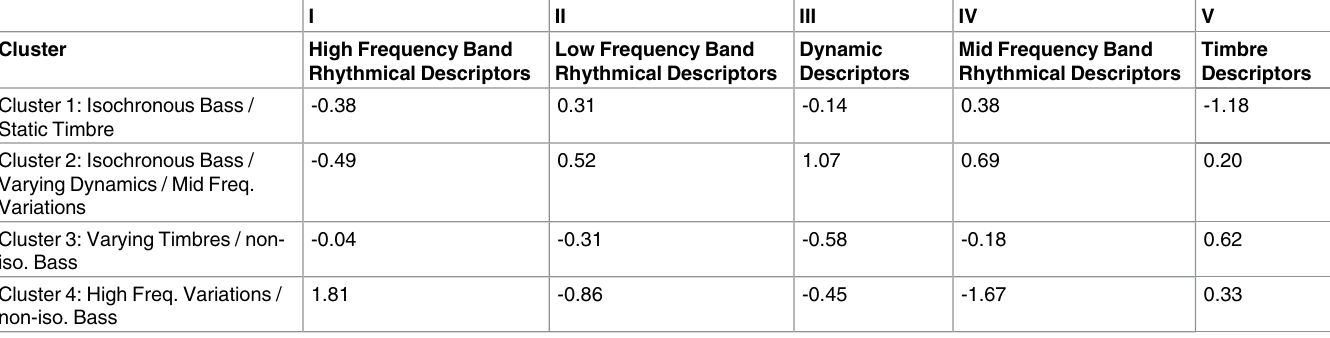
Table 2. Final Four Cluster Centers by Five Factors comprising 19 low-level audio descriptors.